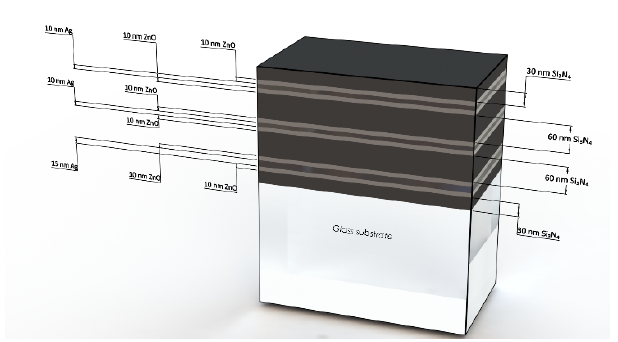
Figure 4. Schematic representation of the adopted film architecture, which is also visible in Figure